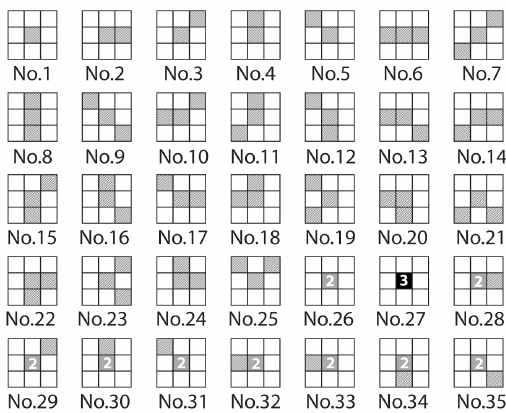
Figure 3. HLAC coding scheme on spectro-temporal local regions.